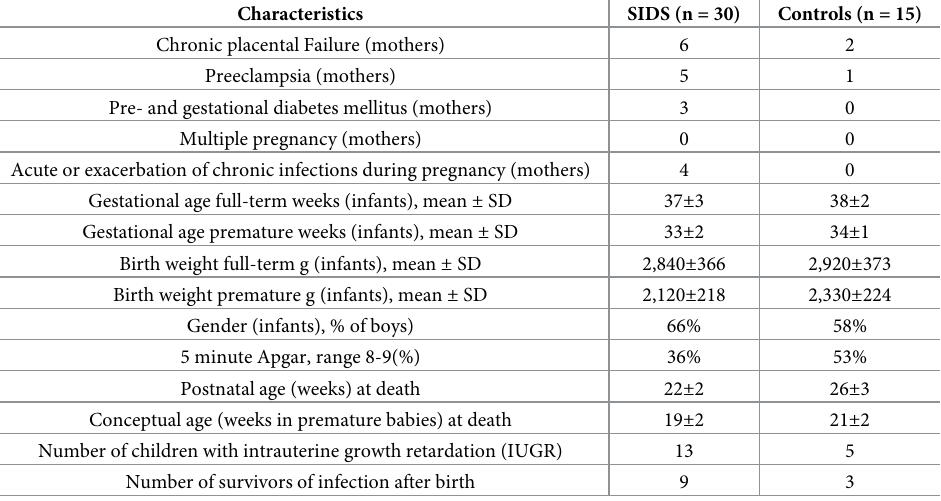
Table 1. The characteristics of the study cohort of